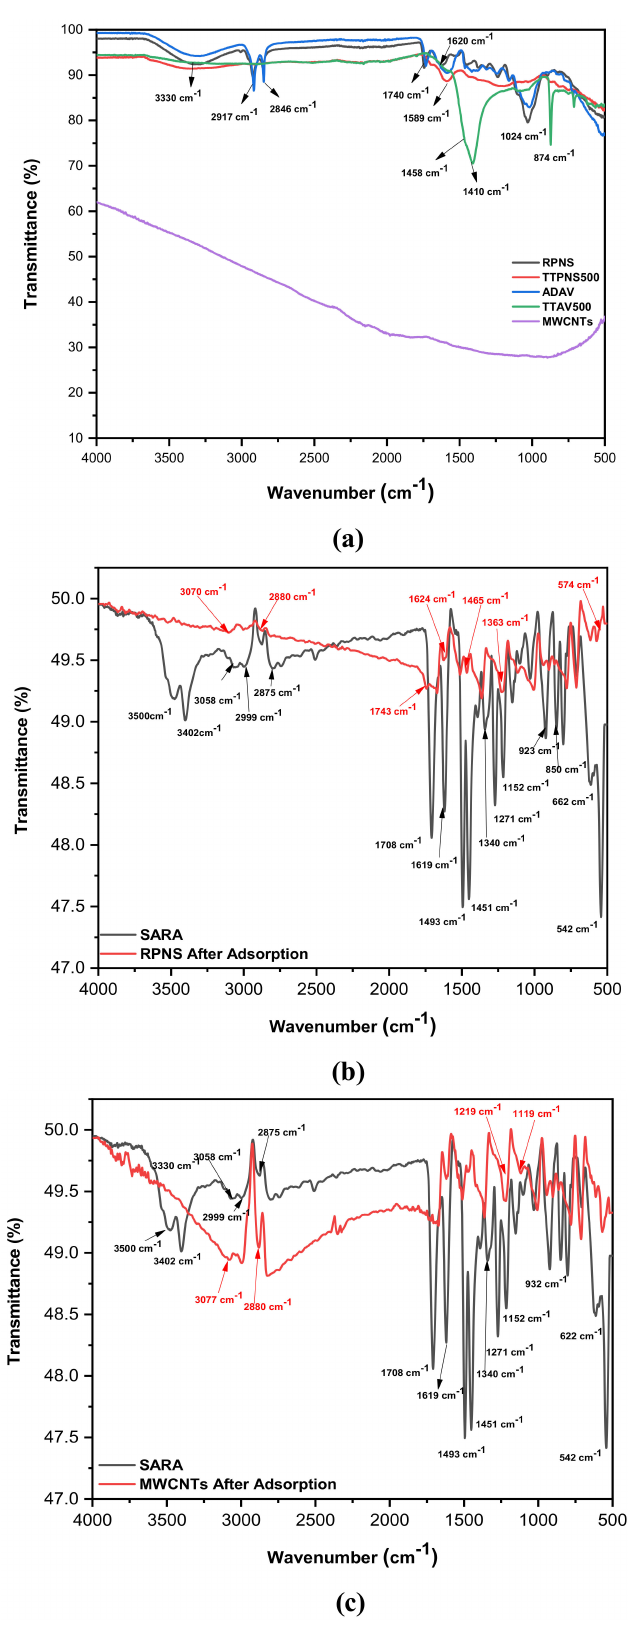
Figure 6. ( a ) FT-IR spectra of tested adsorbents before adsorption, ( b ) SARA and RPNS after adsorption and ( c ) SARA and MWCNTs after